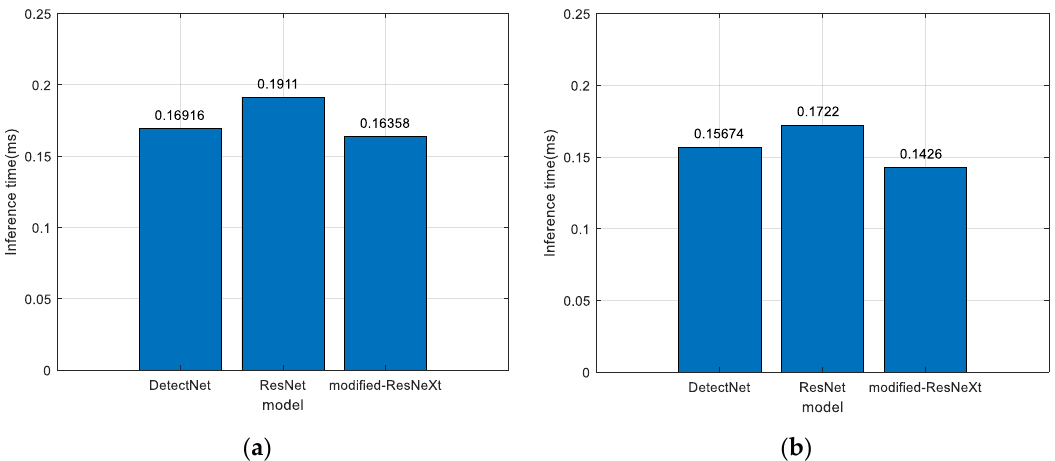
Figure 3. Inference time of various deep learning models. ( a ) Inference time under urban environment; ( b ) Inference time under highway environment. Table 2. Comparison of attributes different deep learning models. The attributes involved in the comparison are parameter amount, model size, and FLOPs.